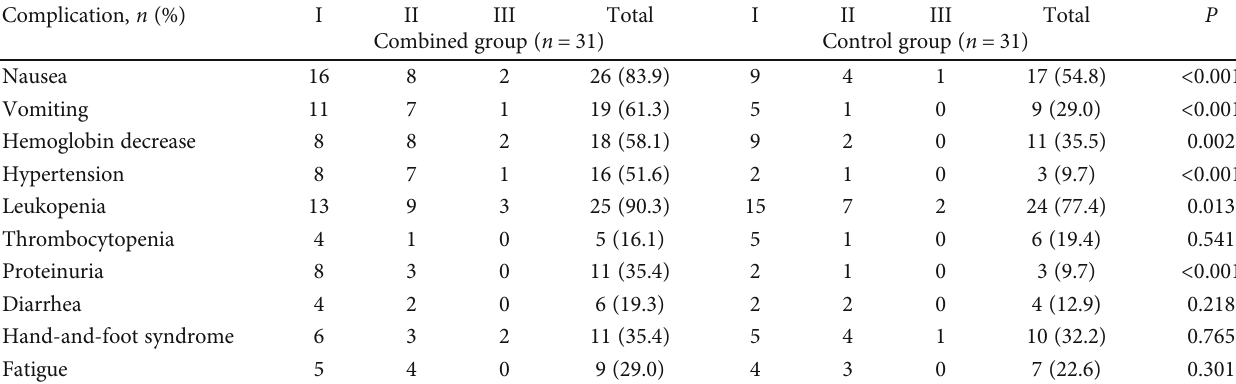
Table 4: Adverse drug reactions for all